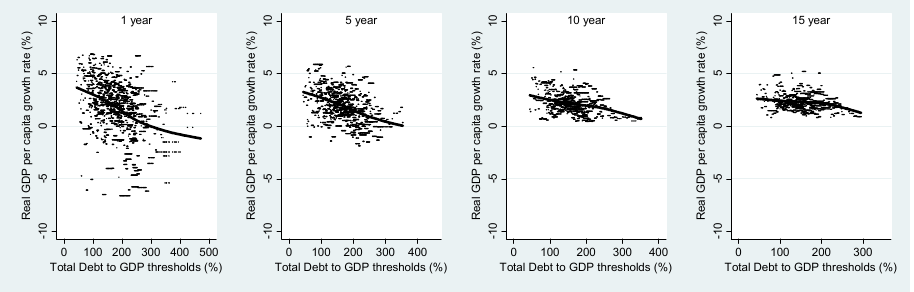
Figure 5 - Total debt and medium- to long-term economic growth (outliers